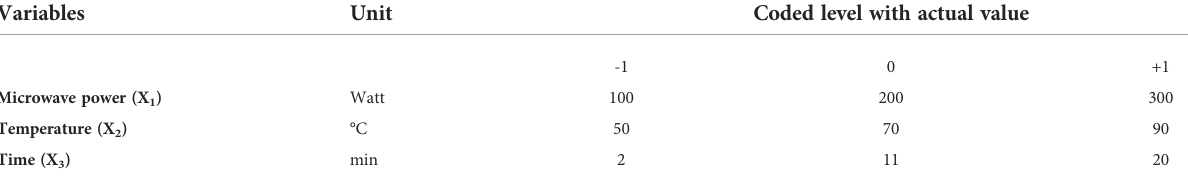
TABLE 1 Coded levels with actual values of different variables for experimental